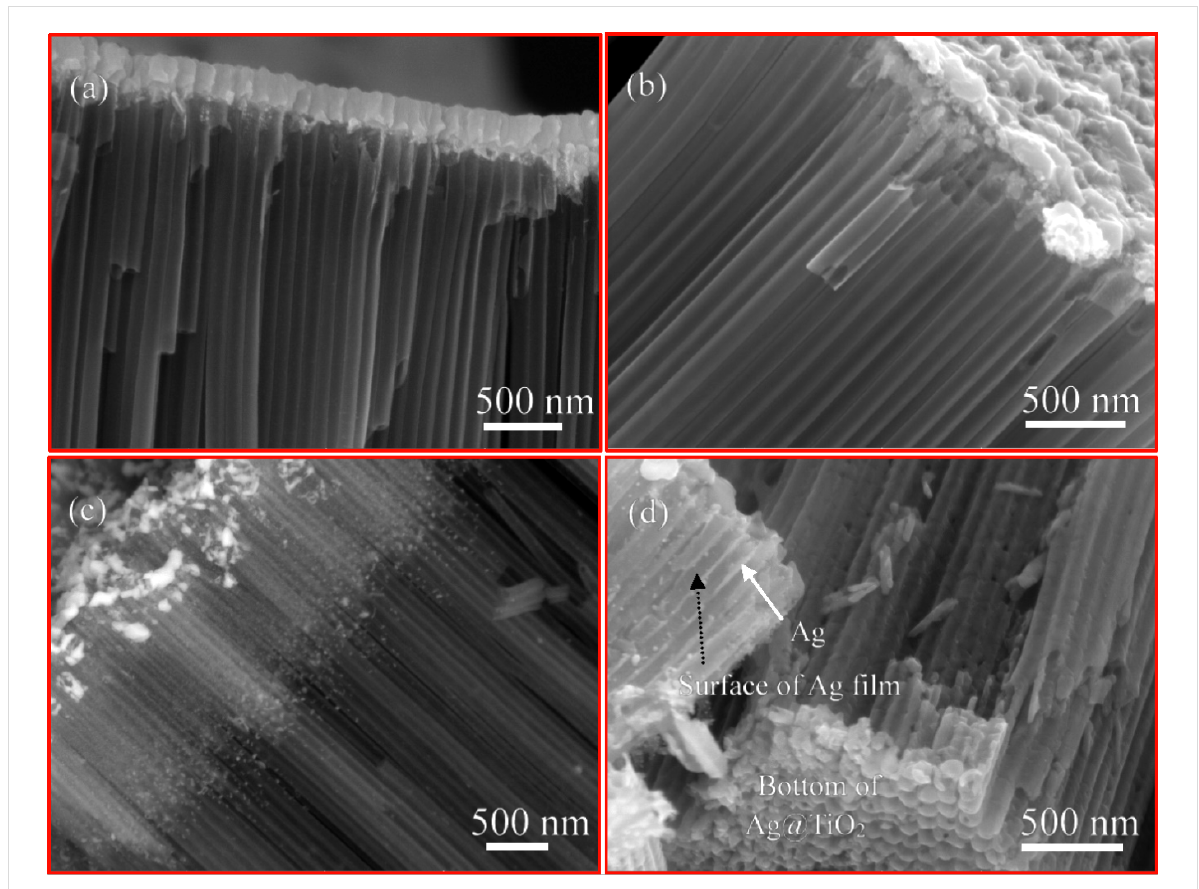
Figure 5: SEM images of the TiO 2 nanotube arrays with Ag nanofilm after different heat treatment for 2 h; (a) without heat treatment, (b) heat treat- ment at 300 °C, (c) heat treatment at 400 °C, and (d) heat treatment at 500